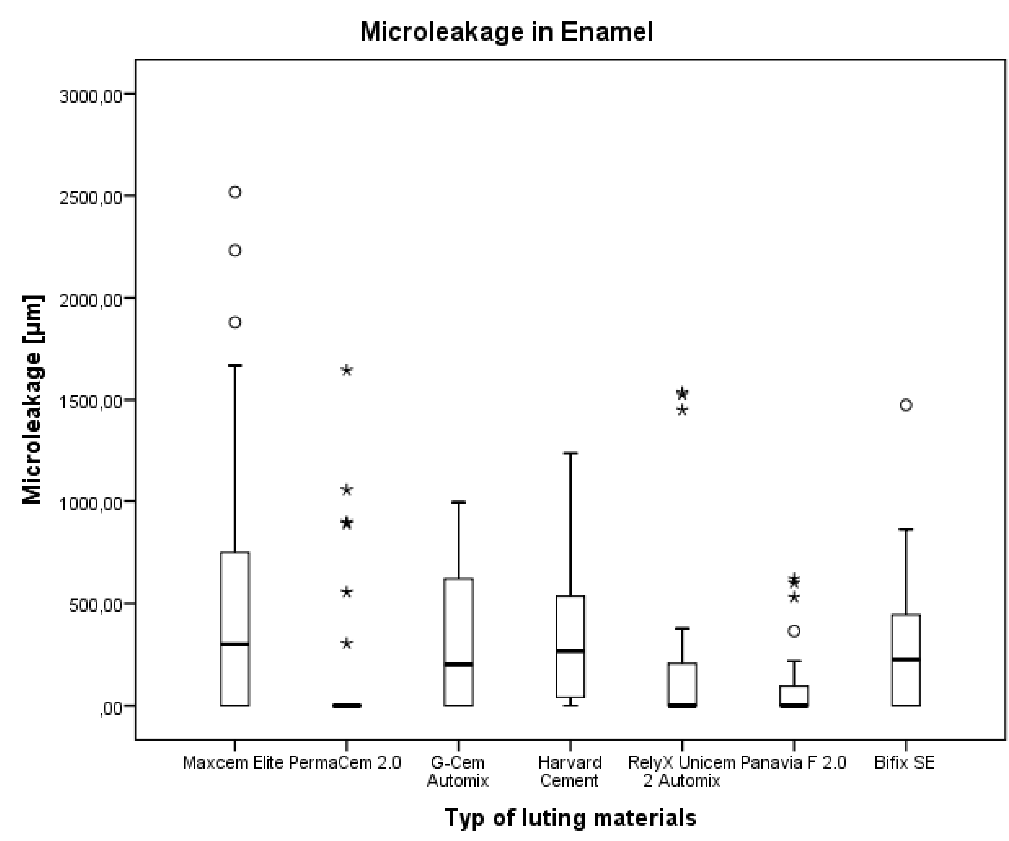
Figure 4. Comparison of the microleakage in enamel for the various luting materials. For description of boxplot, see Figure 3.